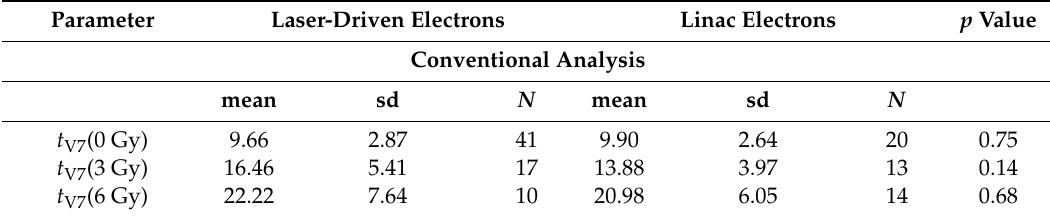
Table 1. Summary of relevant parameters returned by the di ff erent statistical methods applied to the experimentally determined tumour growth data in dependence on dose ( D ). Units (days, Gy) are ignored for